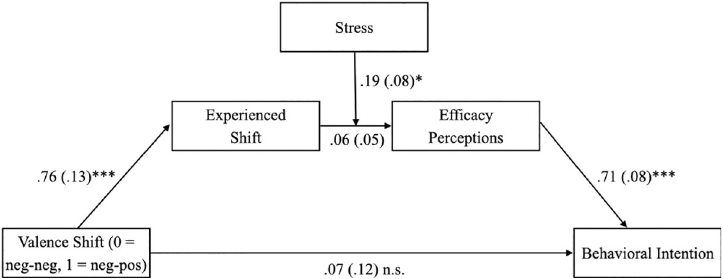
Fig 3. Unstandardized coefficients for moderation of mediation effect of stress. Standard errors are shown in parentheses. Indirect effect stress -.65: B = -.03, SE = .04, 95% CI [-.11, .03]. Indirect effect stress -.01: B = .03, SE = .03, 95% CI [-.02, .09]. Indirect effect stress .55: B = .09, SE = .04, 95% CI [.02, .17]. Index of moderated mediation: B = .10, SE = .05, 95% CI [.03, .21]. � p < .05. �� p < .01. ��� p <